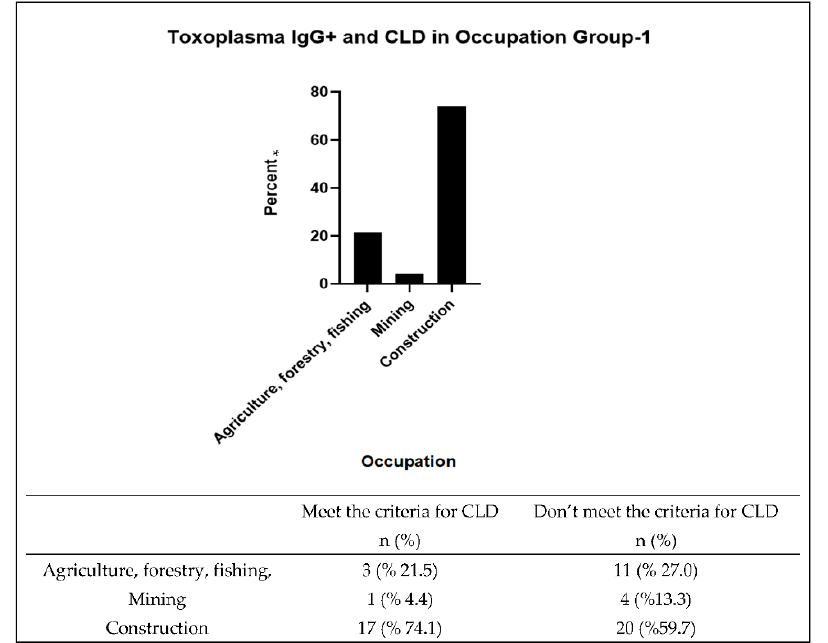
Figure 2. Occupation Group 1 Toxoplasma and CLD. * Percent of T. gondii IgG+ with CLD.